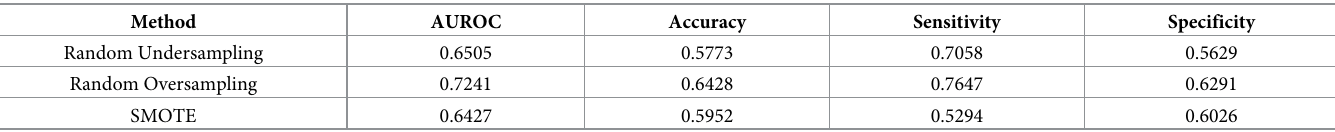
Table 3. Comparison of imbalanced data set sampling methods.